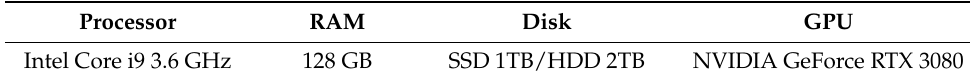
Table 4. Characteristics of the used